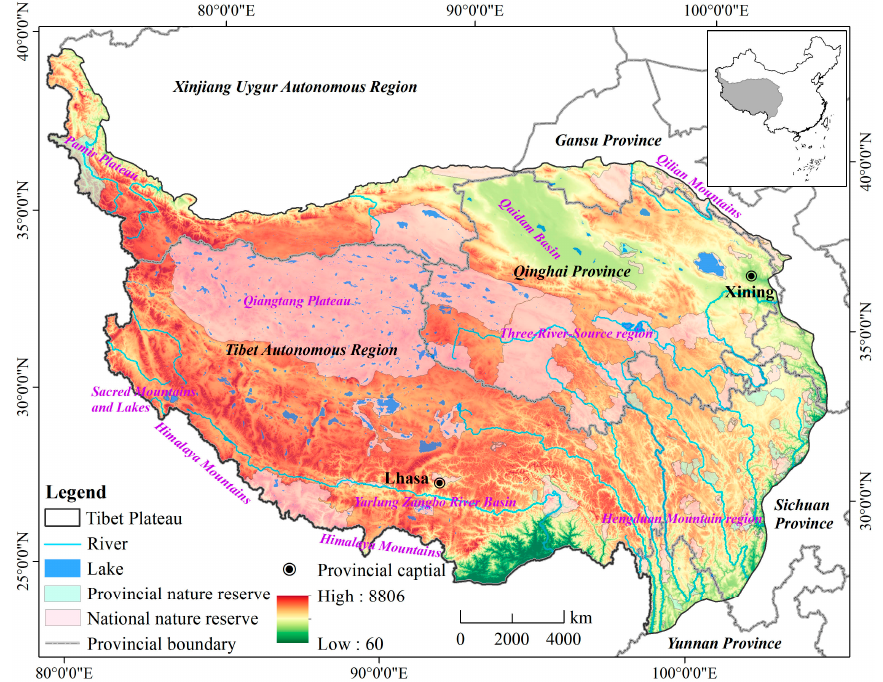
Figure 1. The location of study area (Map number: GS (2020)4619).